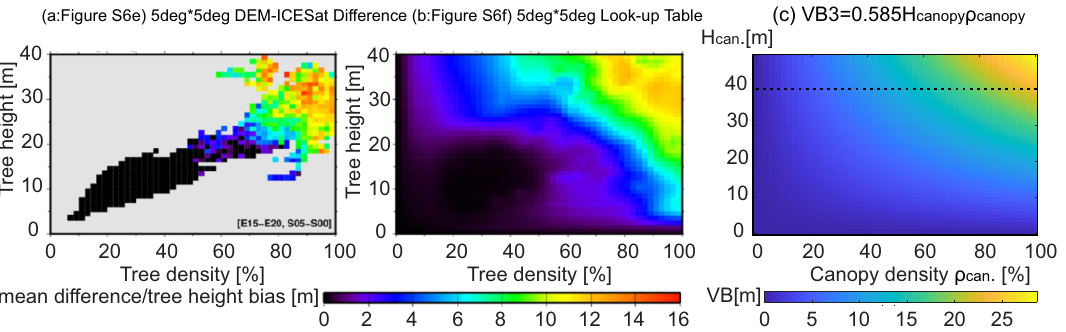
Figure 17. Vegetation bias models: ( a ) Regional dependence between tree densities and tree heights obtained by DSM and Ice, Cloud,and land Elevation Satellite (ICESat) differences; Figure S6e in [4]. ( a ) VB look-up table for the same region; Figure S6f in Yamazaki et al., 2017 [4]. ( c ) The equivalent of (b) for the VB3 model computed as aH canopy ρ canopy . Note that colour bars and vertical axes are